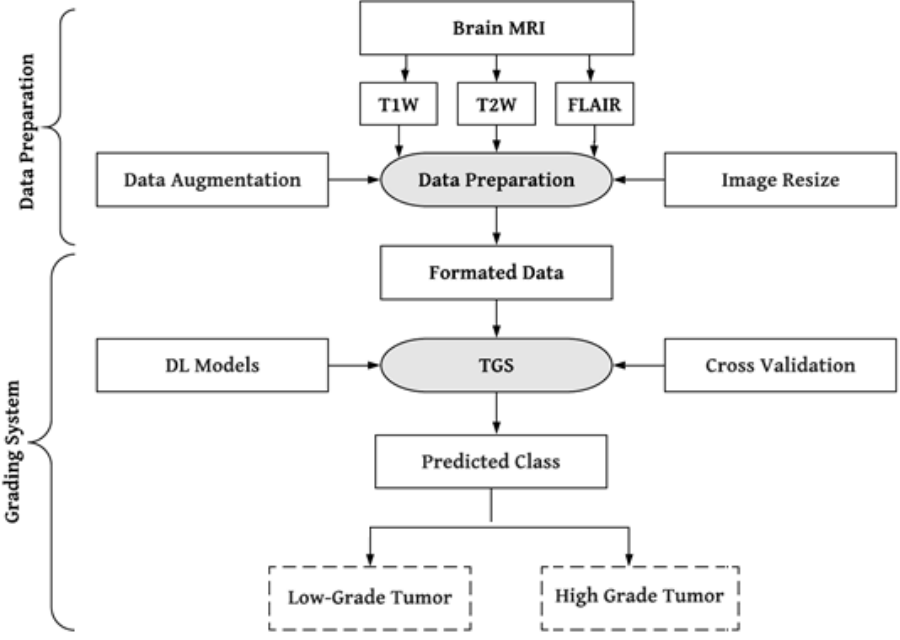
Figure 1. A global picture of brain tumor grading system. T1W: T1-weighted, T2W: T2-weighted, TGS: tumor grading system.